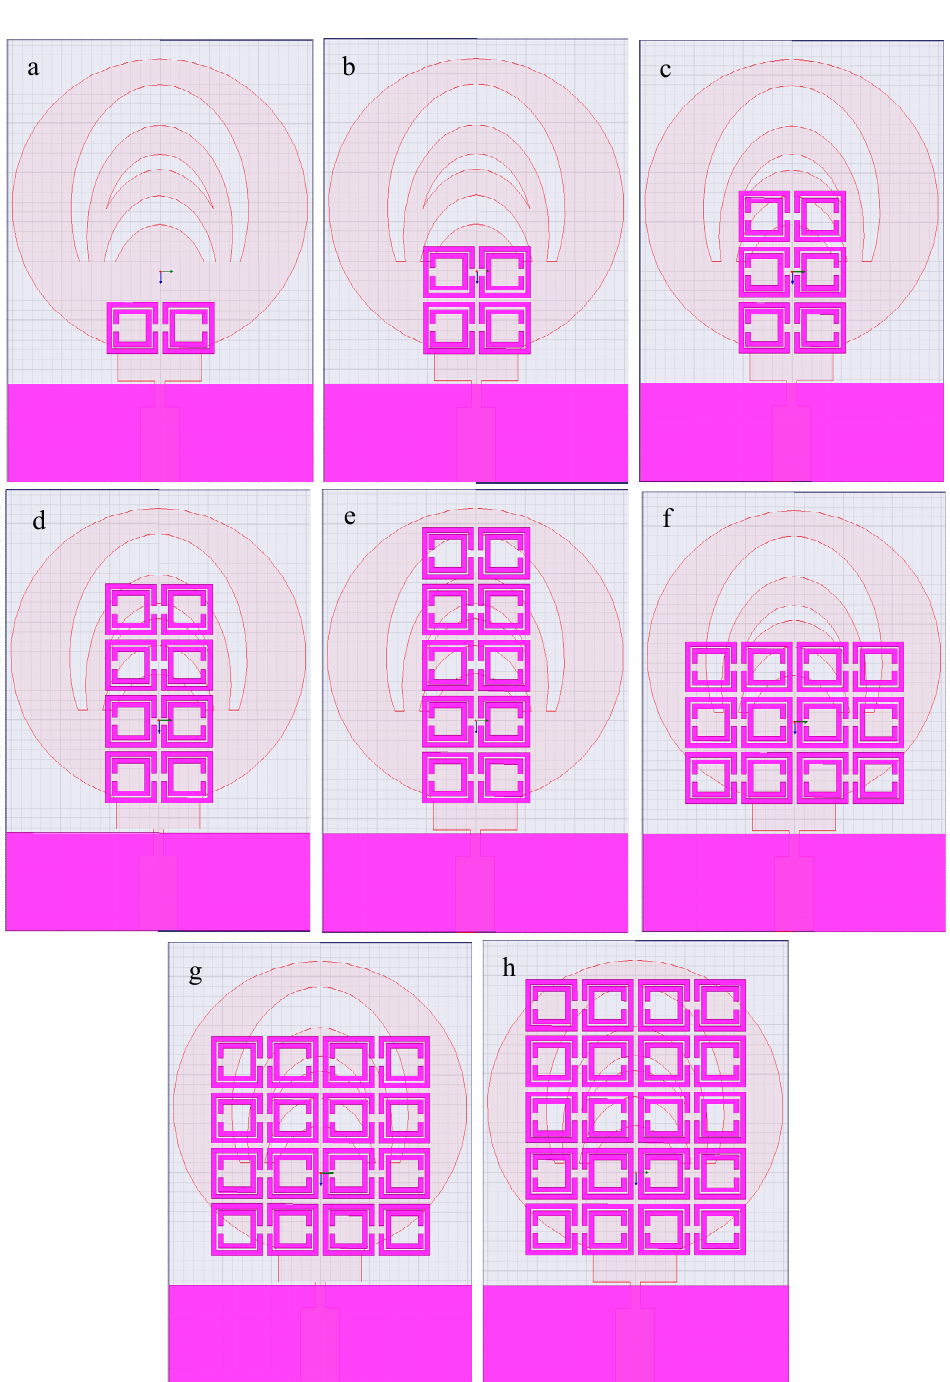
Figure 39. Implementation of S-CRR arrays. ( a ) 2 × 1 ( b ) 2 × 2 ( c ) 2 × 3 ( d ) 2 × 4 ( e ) 2 × 5 ( f ) 3 × 4 ( g ) 4 × 4 ( h ) 4 × 5.